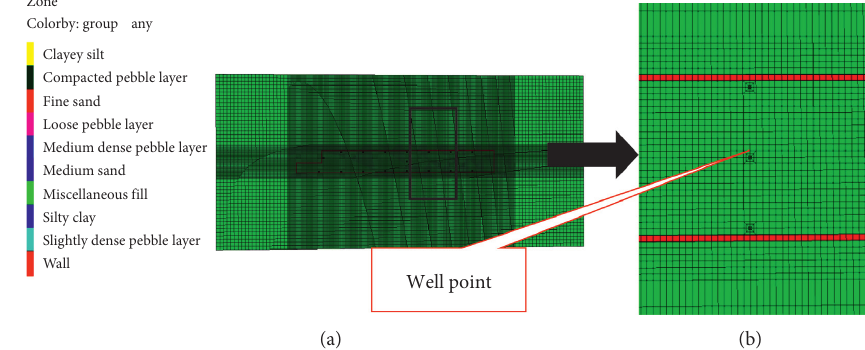
Figure 24: Layout of group wells in the model.